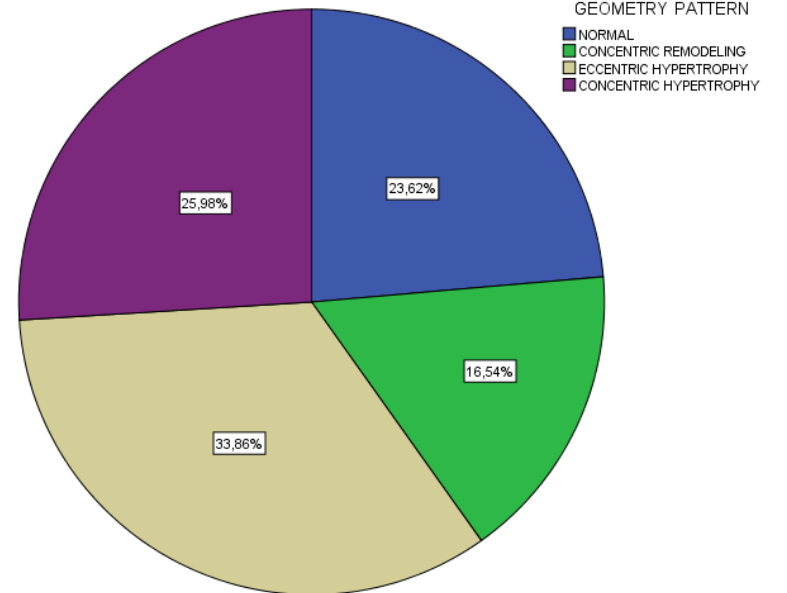
Figure 2. Distribution of cardiac geometry patterns ( n = 127 chronic kidney disease patients on dialysis). There was a progressive decrease ( p = 0.032 for the trend) in MDS from the normal group (24.9 ± 3.5) to concentric remodeling (25.9 ± 2.9), eccentric (24.1 ± 2.8), and then to